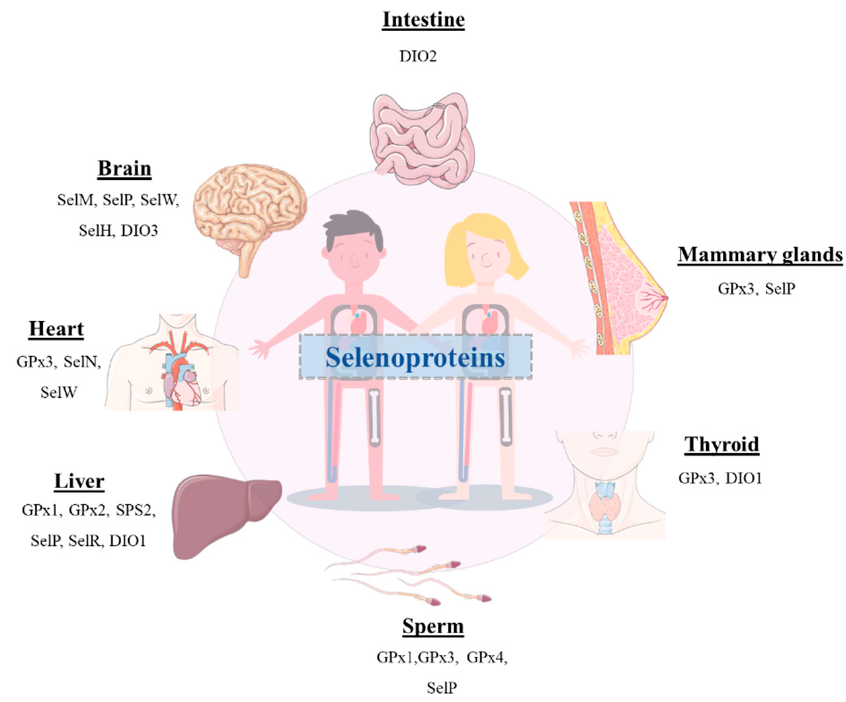
Figure 1. Schematic representation of the presence of several selenoproteins in different organs of the human body.